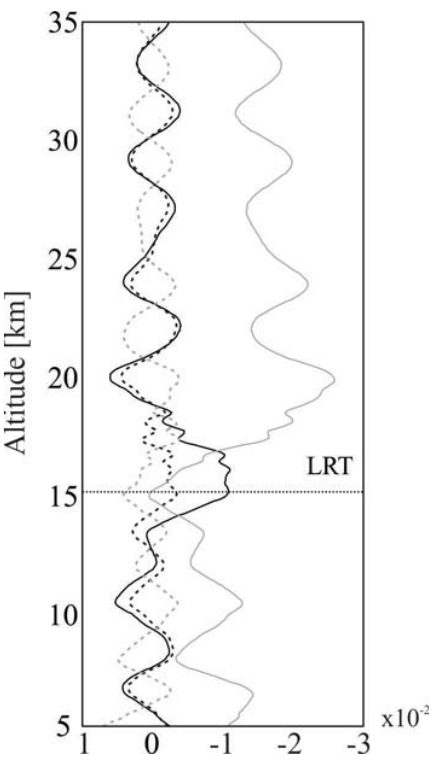
Fig. 5. Bandpass (solid) and double filtered (dashed) relative tem- perature (black) and refractivity (gray) profiles of a GPS RO event (Satellite COSMIC 1, lon=18.06 ◦ , lat= − 36.30 ◦ , 19 July 2010, 19:07UTC).